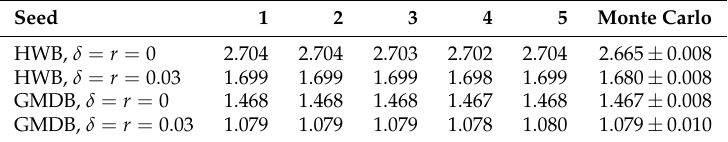
Table 2. Price estimates for δ = r and varying seeds.